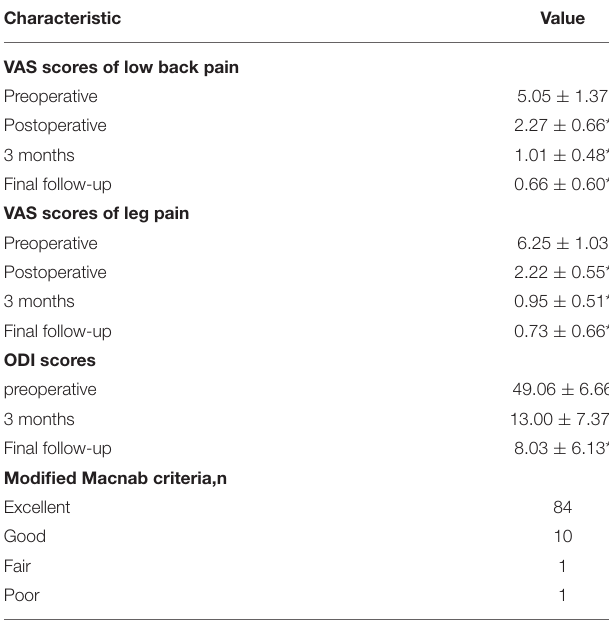
TABLE 2 | Follow-up outcomes (VAS, ODI, modified Macnab